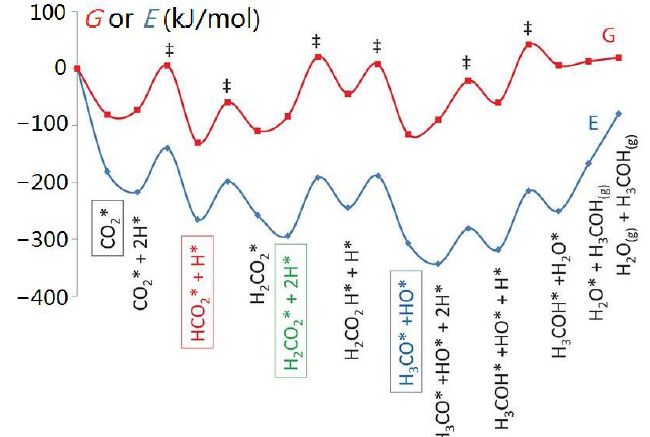
Figure 5. Energy ( E ) and standard Gibbs free-energy ( G ) pathway calculated for the CO 2 hydrogena- tion to methanol over Cu/ZrO 2 . Reproduced with permission from Larmier et al. [81], published by John Wiley and Sons, 2017.